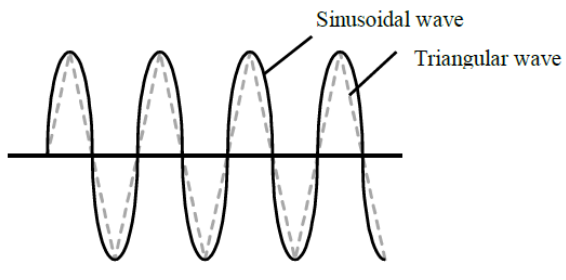
Figure 11. Modulation